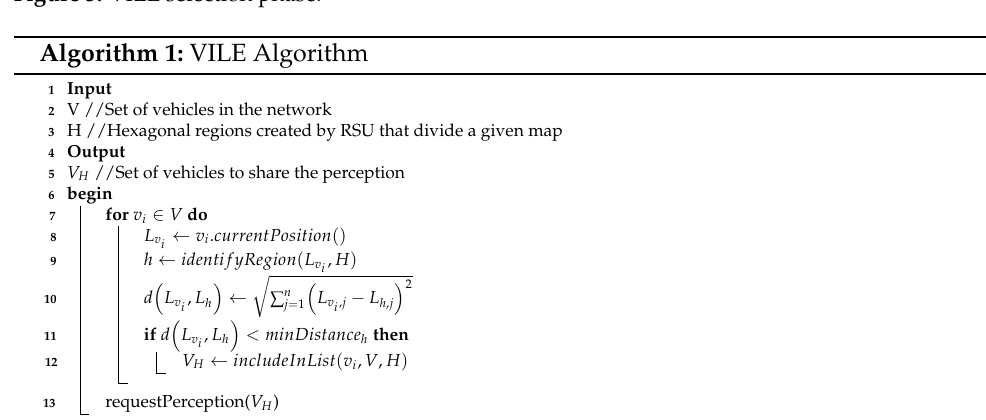
Figure 3. VILE selection